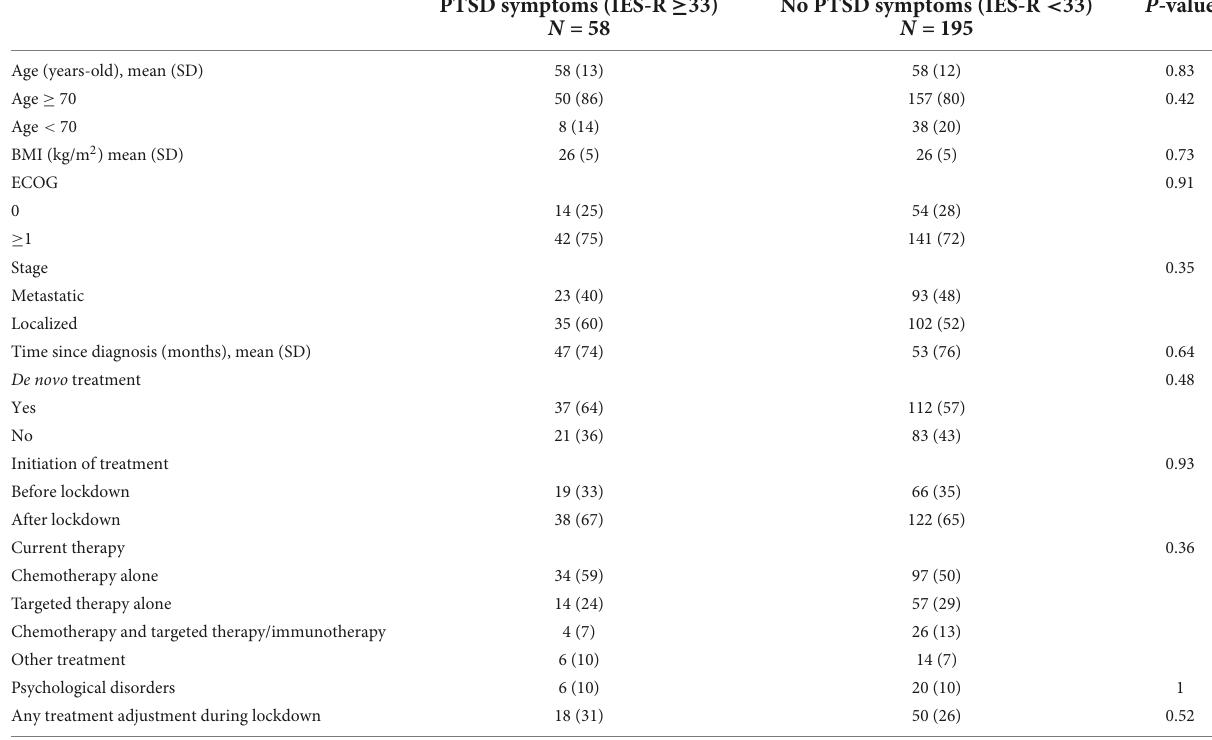
TABLE 3 Characteristics of patients by post-traumatic stress disorder (PTSD) symptoms ( N = 253).